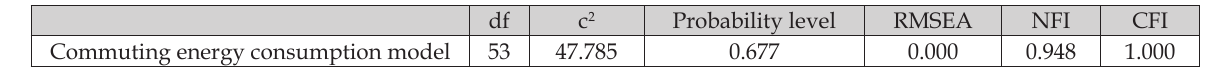
Table 5. Fit indices of the energy consumption of commuting model.